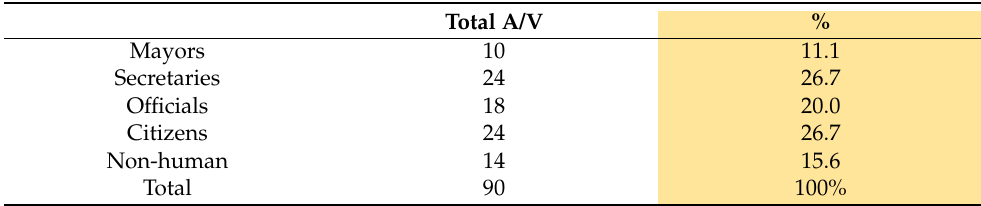
Table 9. Protagonist of TV images (Source: